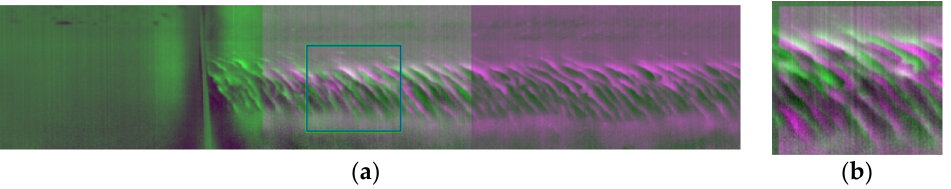
Figure 7. ( a ) Overlapping of two consecutive phase images with marked region of interest for phase correlation; ( b ) shift of the second image according to the result of the phase correlation.